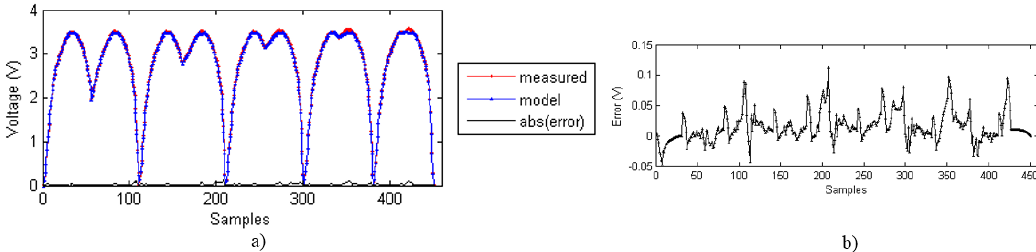
Figure 12. ( a ) Measured data, ELAM model and absolute value of the error; ( b ) Error